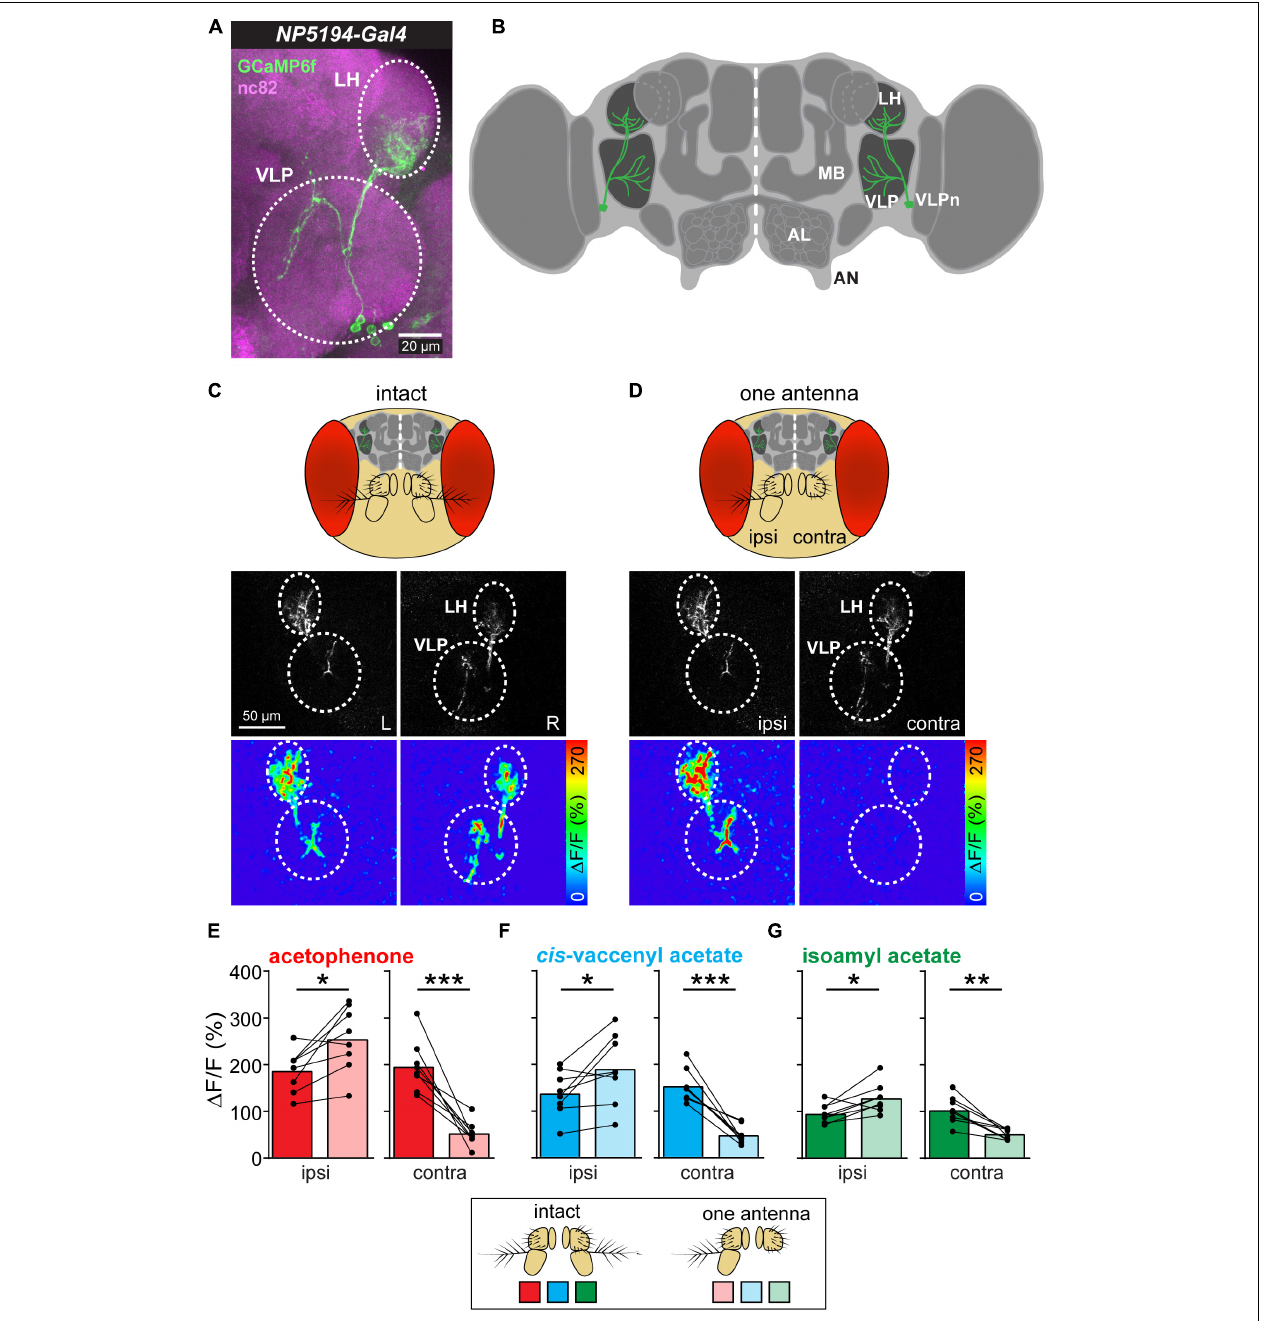
FIGURE 1 | Asymmetric odor stimulation induces contralateral suppression. (A) Confocal z-projections of VLPn labeled by NP5194-Gal4 in an adult female brain. Labeling of GFP (green) and the neuropil marker nc82 (magenta) are shown. Dashed circles represent the lateral horn (LH) and ventrolateral protocerebrum (VLP). Scale bar = 20 µ m. (B) Schematic illustration of the Drosophila brain showing the innervation pattern of the VLPn in the LH and the VLP. Mushroom body (MB), antennal lobe (AL), and antennal nerve (AN) are shown for orientation. (C,D) Upper panel : Schematic head of Drosophila with intact antennae (C) and after removal of the third antennal segment of one antenna (D) . Middle panel : Gray-scale image represents the VLPn structure expressing GCaMP6f. Dashed circles indicate the LH and the VLP in the left (L) and right (R) brain hemispheres. Scale bar = 50 µ m. Lower panel : false-color coded images showing odor-evoked responses from a representative animal before (C) and after (D) antennal removal. Dashed circles represent the LH and VLP. (E–G) Calcium signals obtained with two-photon imaging from flies bearing UAS-GCaMP6f under control of NP5194-Gal4 from the ipsi- and contralateral sides (to the intact antenna) before and after antennal removal to stimulation with acetophenone (E) , cis -vaccenyl acetate (F) , and isoamyl acetate (G) . Dots and lines represent individual flies, bars represent the mean ( n = 8; ∗ p < 0.05; ∗∗ p < 0.01; ∗∗∗ p < 0.001, paired t -test).